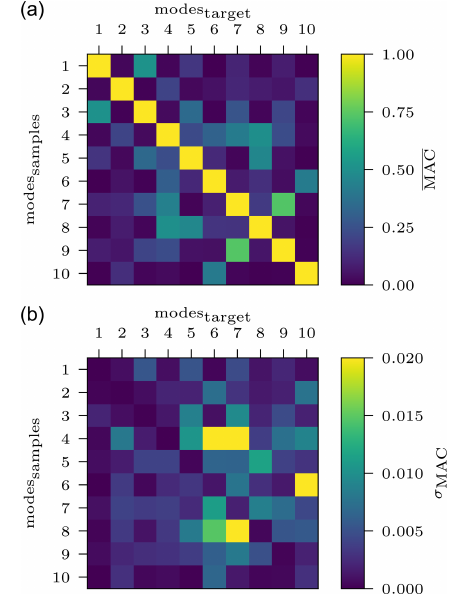
Figure 18. Mean and standard deviation of the natural frequency error e f computed for 1000 target